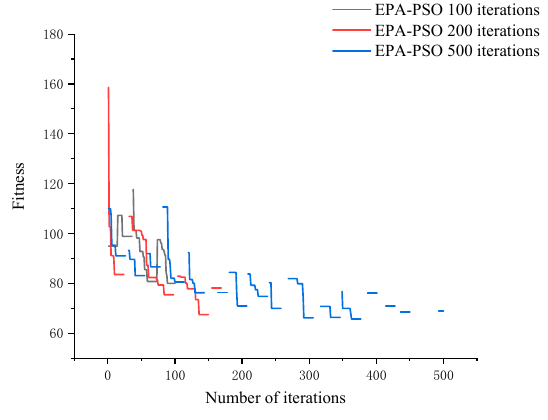
Figure 6. Fitness of EPA-PSO algorithm.